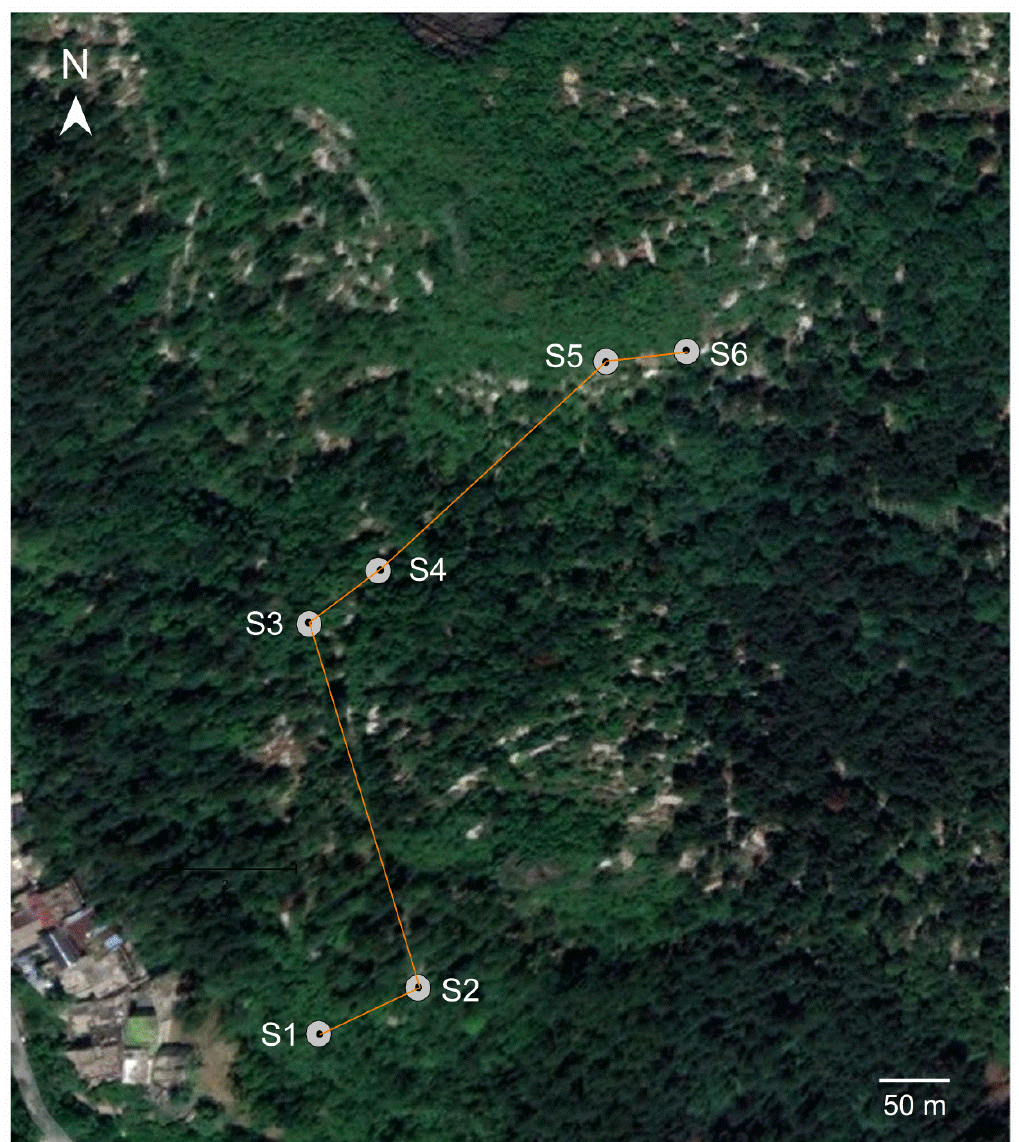
Figure 1. Location of sampling sites (S, circles) near Nanming District, Guiyang, southwest China (adapted from Google Map). Table 1. Common species in plots of different altitudes. S1 ‒ S6 represented six plots established on three altitudes.